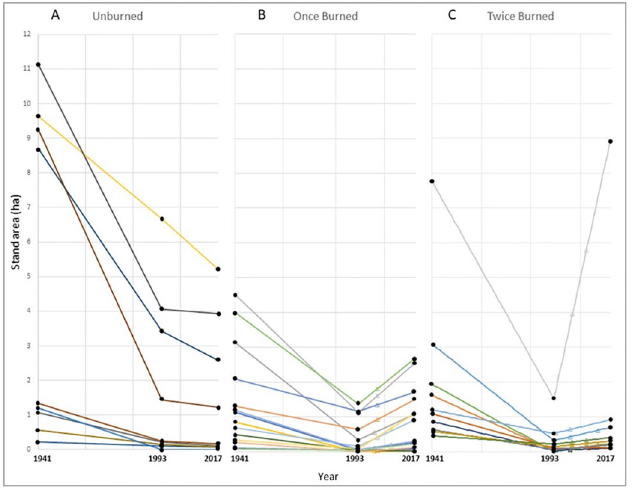
Fig 4. Stand area change over time for individual aspen stands in each fire frequency category: Unburned (A), once-burned (B) and twice-burned (C). Triangles denote years where a stand burned between 1993 and